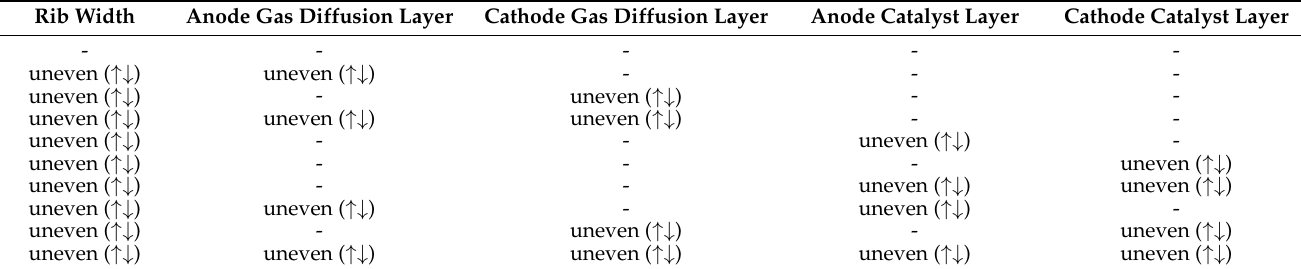
Figure 2. Schematic diagram of the uneven design structure. Table 3. Design of numerical experiments for the PEMFC uneven design.